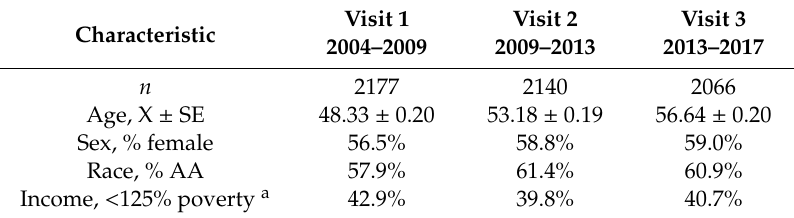
Table 1. Demographic characteristics of the Healthy Aging in Neighborhoods of Diversity across the Life Span (HANDLS) study participants by